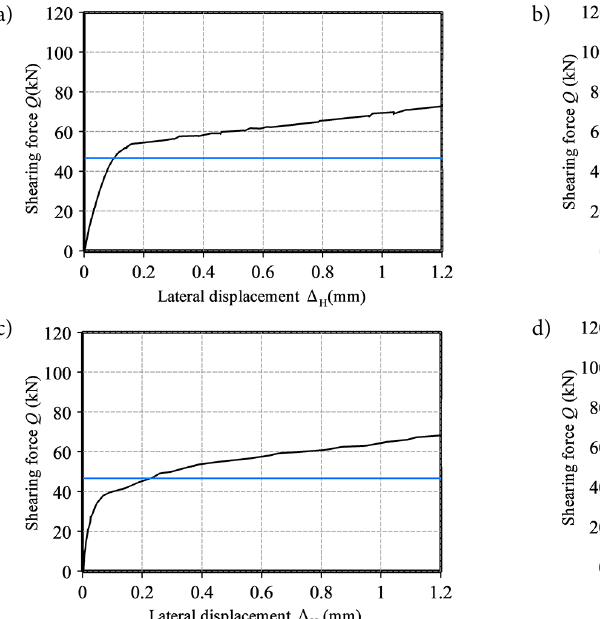
Figure 21. Relations between Q and ∆ H : a – SL-45-1; b – SL-45-2; c – SL-45-3; d